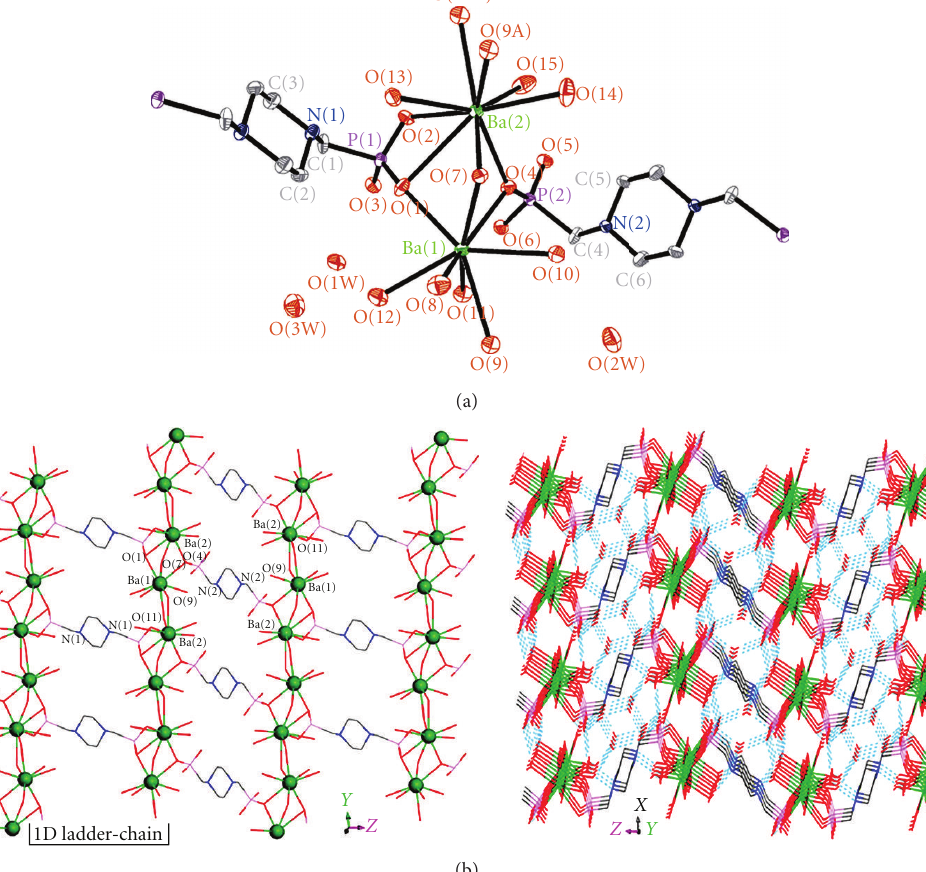
F 1: (a) Molecular structure of 1 showing the atom-labeling scheme (50 and organic linker in the bc plane (le), and the 3-D supramolecular network of 1 stacked by hydrogen bonds along the y -axis (right) (Green: Ba, Pink: P, Grey: C, Red: O, Blue: N, White: